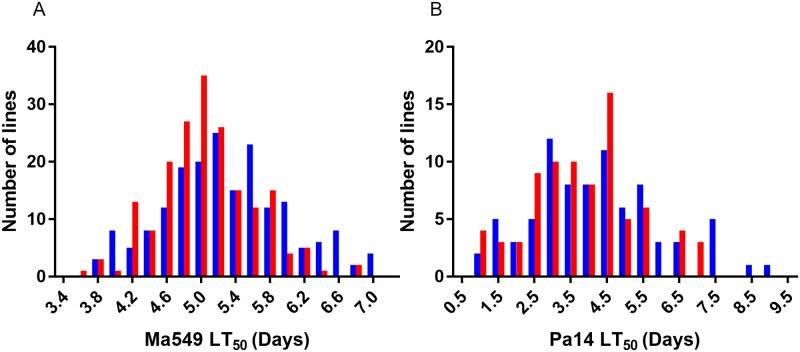
Distribution of male (blue bars) or female (red bars) lifespans among DGRP lines infected with Ma549 (A) or Pa14 (B).Lifespans were measured as the time required for half the flies to die (LT50).